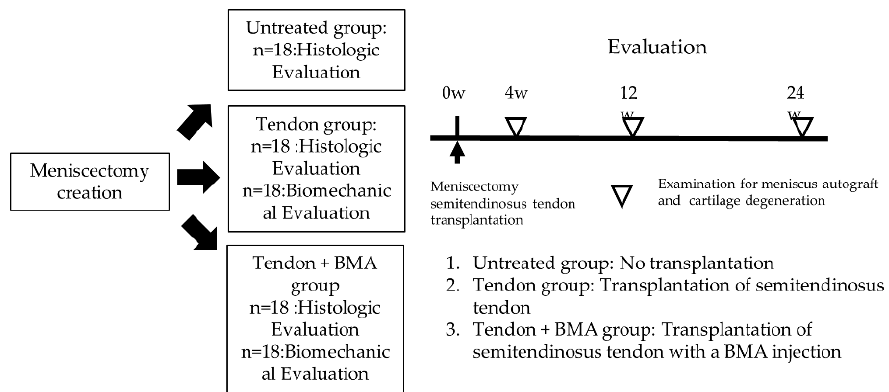
Figure 9. Study protocol. Rabbits were sacrificed at 4, 12, and 24 weeks after surgery ( n = 6 at each time point), and the macroscopic and histological findings among the three groups were compared. Meanwhile, biomechanical comparisons between the tendon and tendon + BMA groups were per- formed at 4, 12, and 24 weeks postoperatively ( n = 6 at each time point).